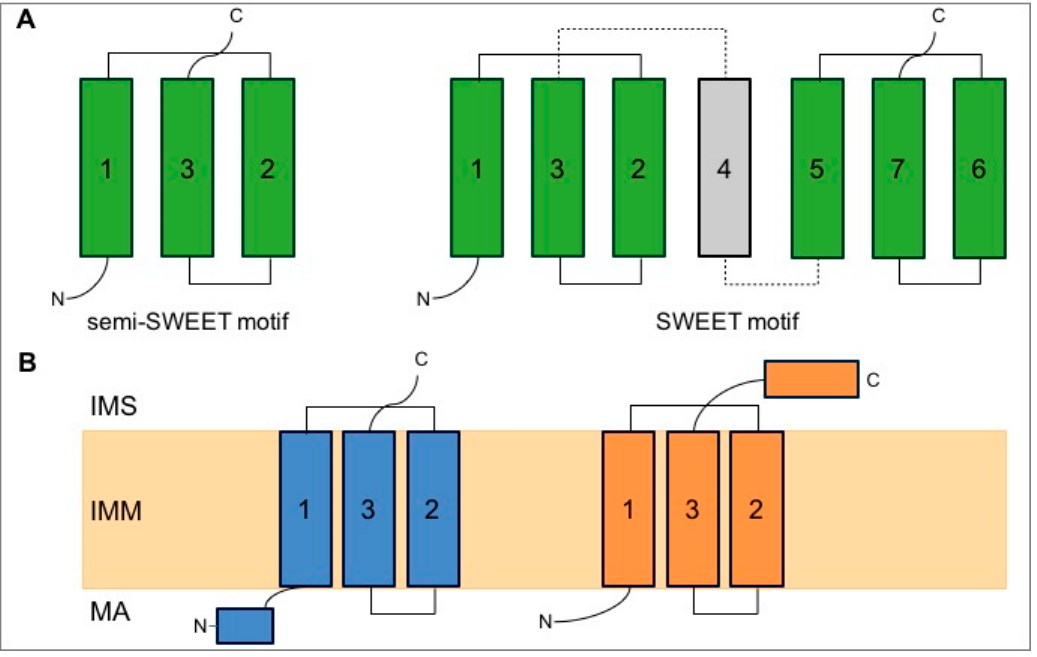
Figure 2. ( A ) Semi ‐ SWEET and SWEET motifs. Semi ‐ SWEET is composed of a triple helix bundle in this specific order 1 ‐ 3 ‐ 2. SWEET contains two semi ‐ SWEET motifs linked together by a helix. All the helices are crossing the membrane. ( B ) Model for the topology of MPC1 and MPC2 in the inner mitochondrial membrane (IMM). Here, a semi ‐ SWEET structure is proposed for both MPC1 and MPC2. MA: matrix; IMS: intermembrane space.